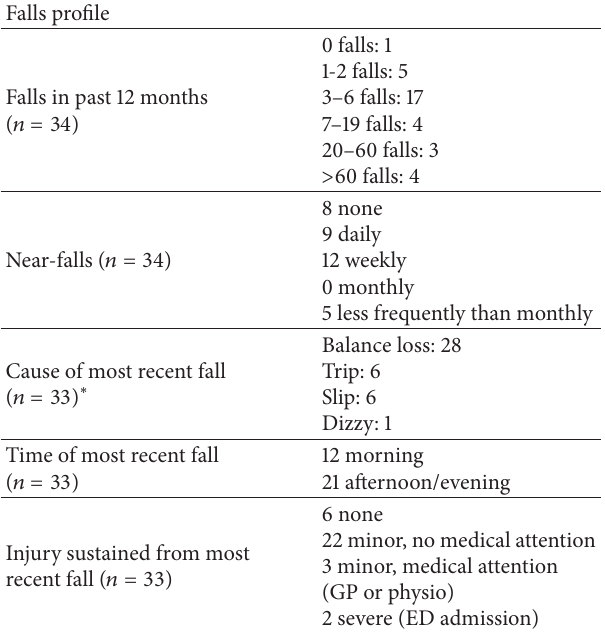
Table 1: Falls data including falls and near-falls number, cause, time of fall, and injury